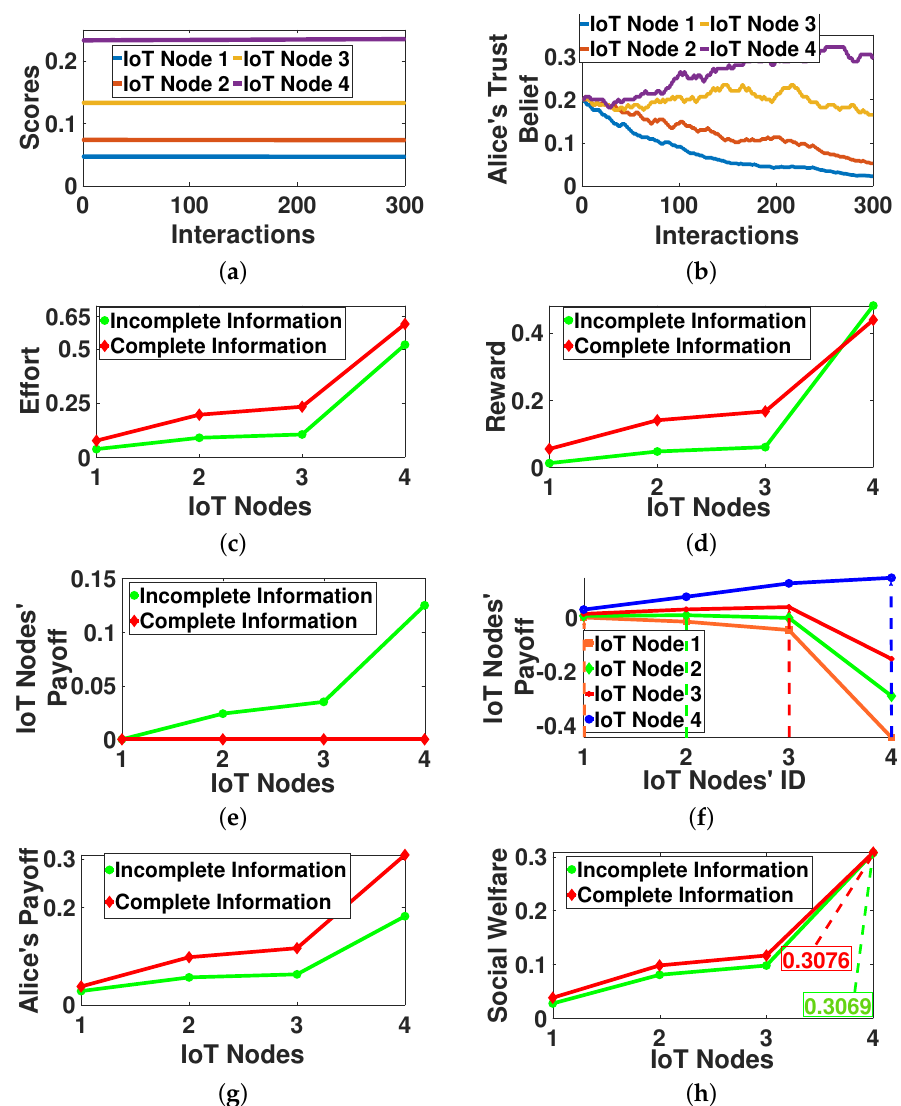
Figure 4. Offline contract-theoretic crowdsourcing—operation and performance evaluation. ( a ) Nodes’ Scores vs. Interactions, ( b ) Alice’s Belief vs Interactions, ( c ) Effort vs. Nodes, ( d ) Reward vs Nodes, ( e ) Nodes’ Payoff vs. Nodes, ( f ) Nodes’ Payoff vs. Nodes IDs, ( g ) Alice’s Payoff vs. Nodes, ( h ) Social Welfare vs.